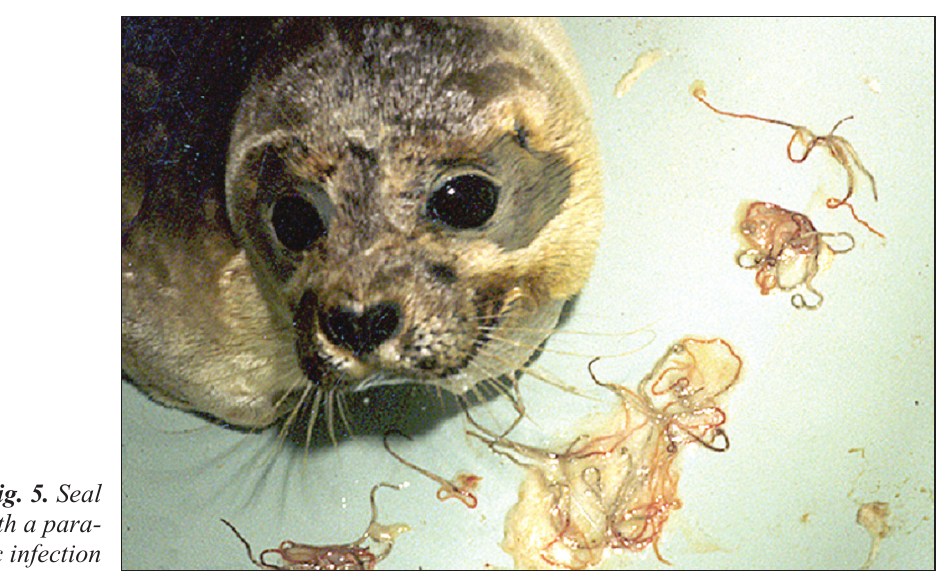
Fig. 5. Seal with a para- sitic